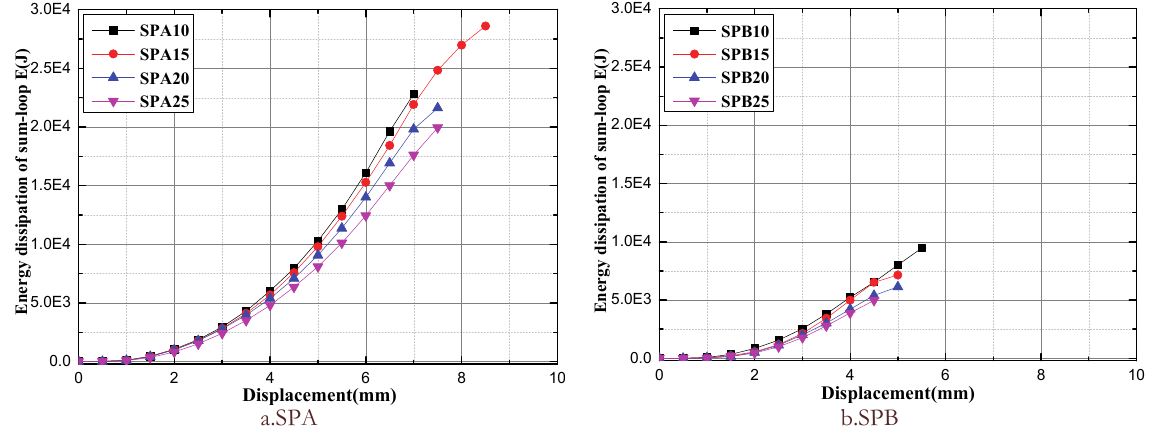
Figure 8: Dissipation capacity comparison of different opening types of dampers with different opening